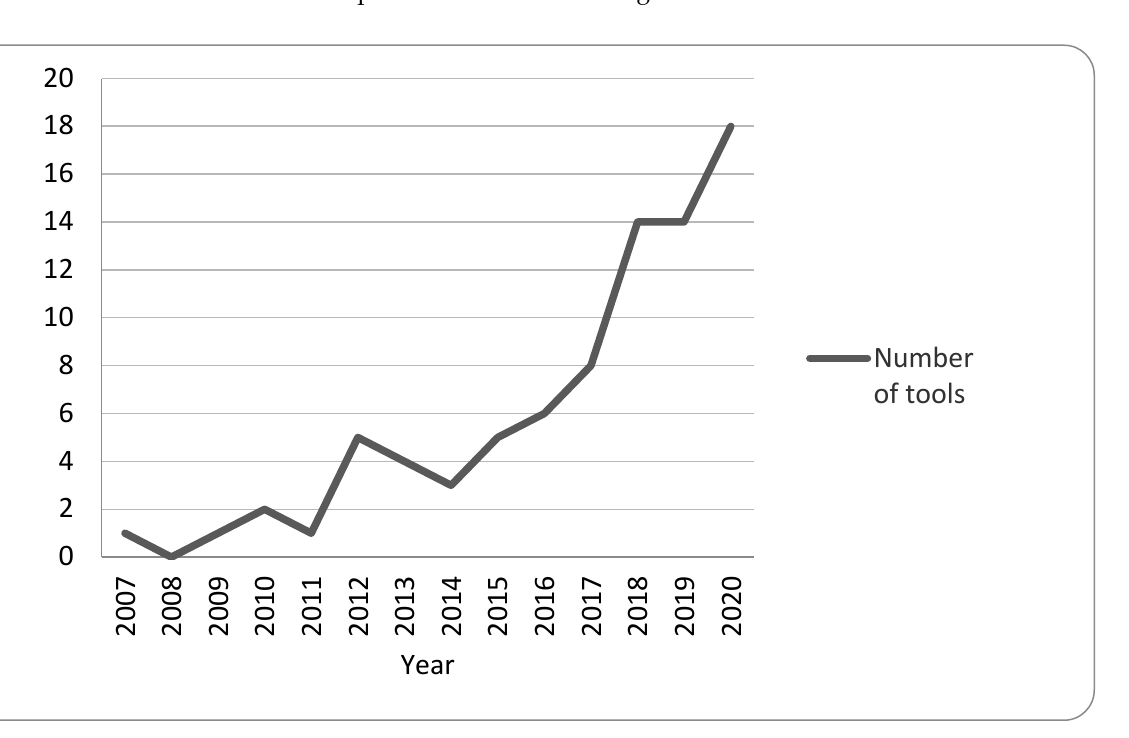
Figure 2. Number of tools found over time.